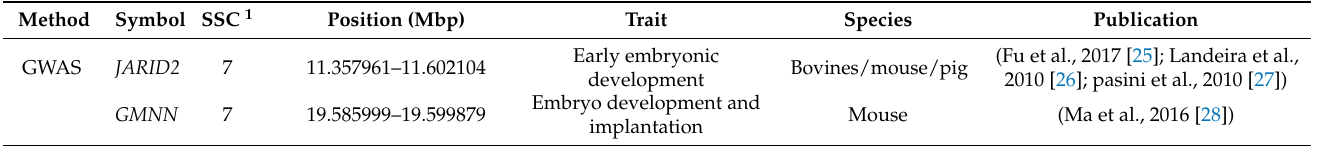
Figure 4. The analysis of 10.5–11.5 Mb region. ( A ) The Manhattan plot of genome-wide association study for NBA trait; ( B ) The Manhattan plot of single-step genome-wide association study for NBA trait; ( C ) genes distributed in 10.5–11.5 Mb region; ( D ) linkage disequilibrium analysis for 10.5–11.5 Mb region. Table 5. Genes for reproductive traits reported in previous study among candidate genes.